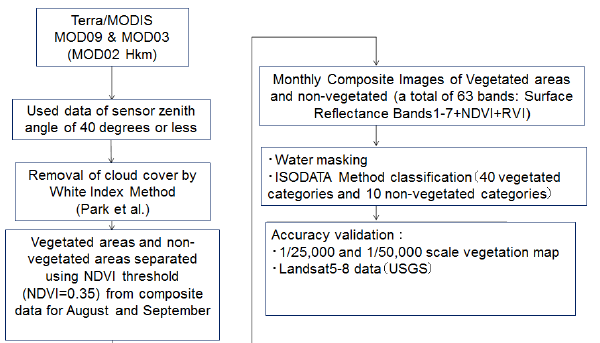
Figure 3. Flowchart for constructing vegetation maps from Terra/MODIS data